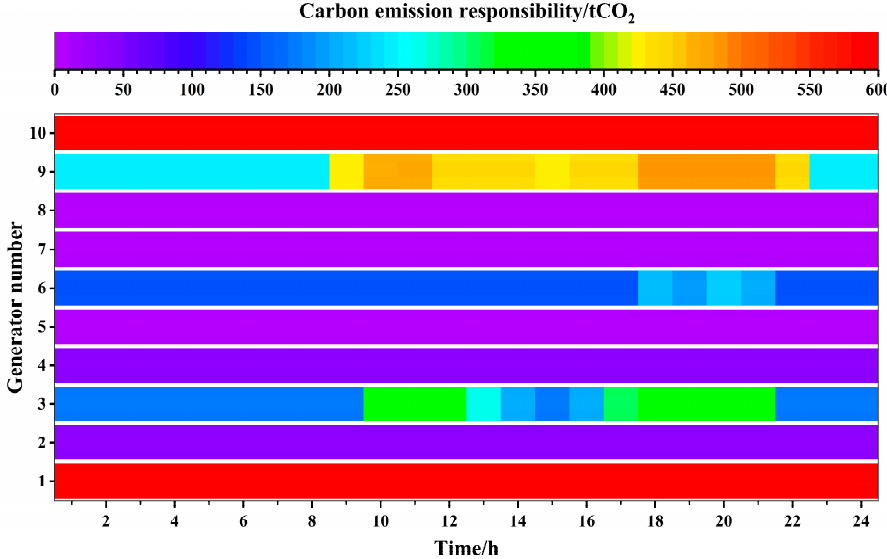
Figure 5. Carbon allowance values of 10 generators.